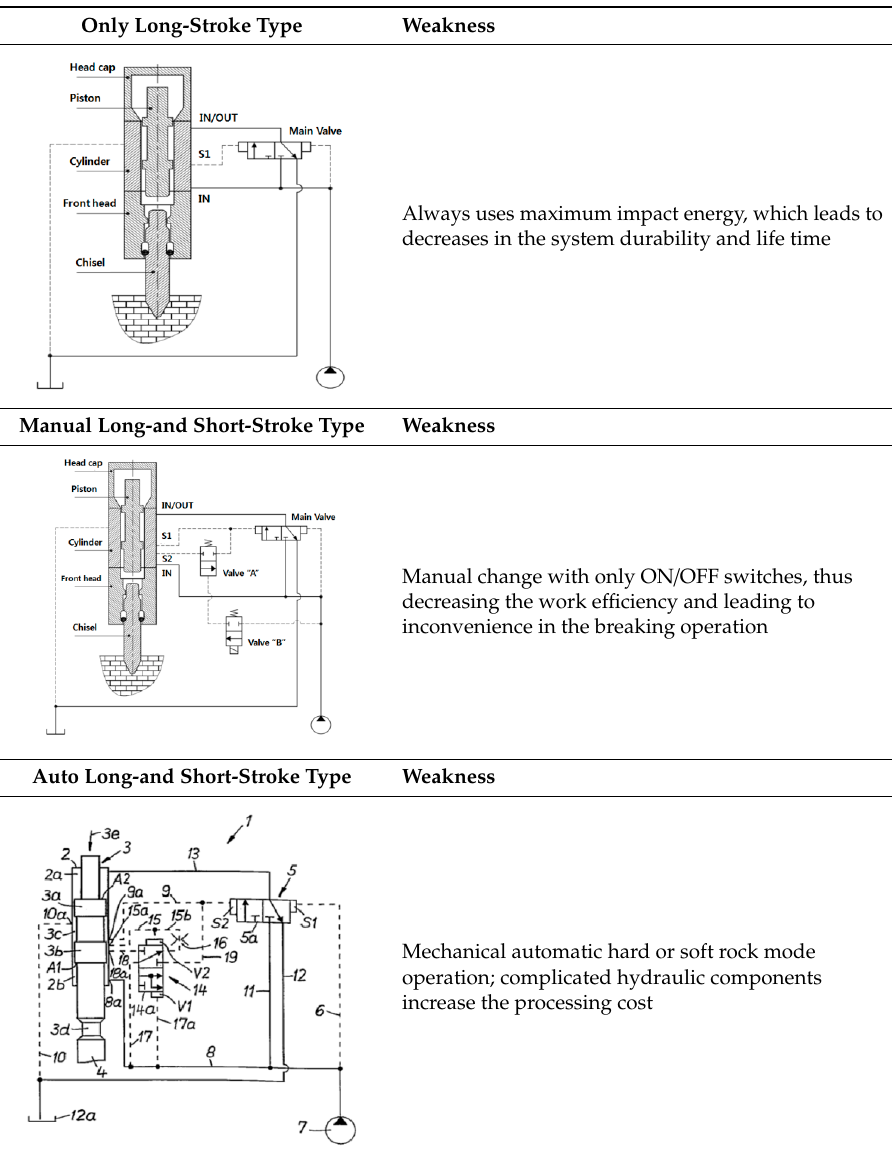
Figure 1. Hydraulic breaker and components. Table 1. Weaknesses of conventional hydraulic breakers.